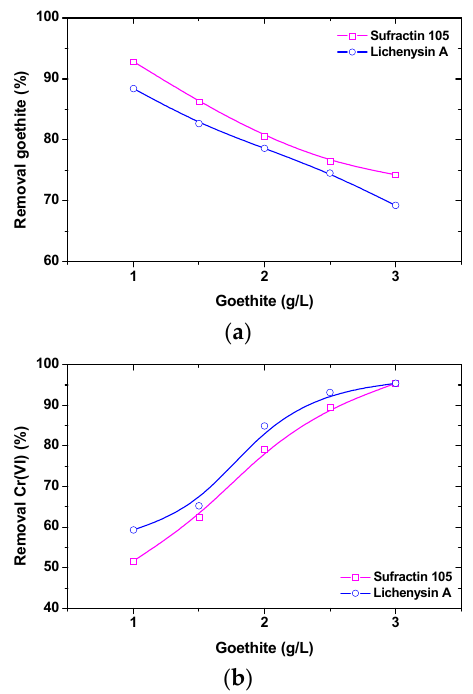
Figure 7. ( a ) Separation of goethite (adsorbent) by flotation, using biosurfactants; and ( b ) separation of chromates by adsorptive flotation, using biosurfactants. Reprinted with permission; copyright Elsevier [59].